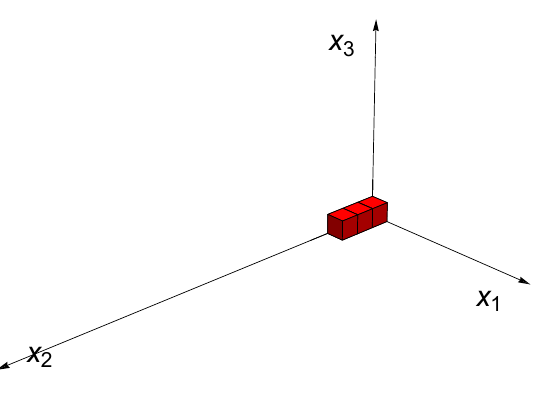
Figure 13 . The con(cid:12)guration